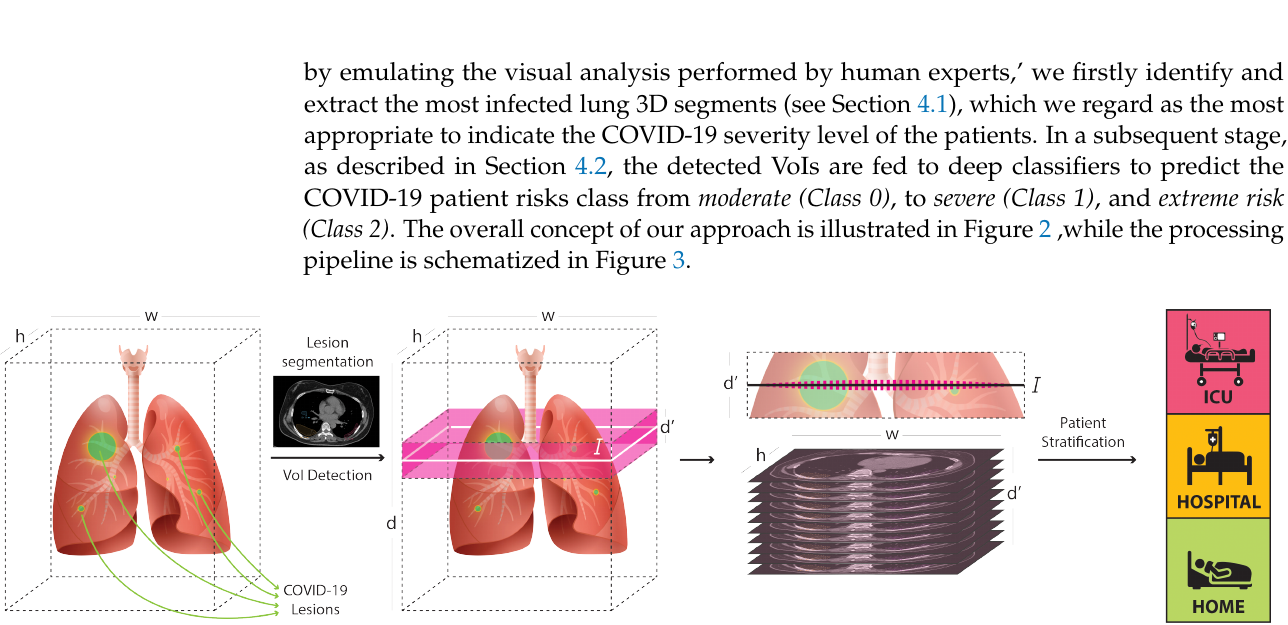
Figure 2. For a CT scan with size w × h × d , where w , h and d are the slice-width, slice-height, and number of slices, respectively, the most informative volume of interest (VoI) is composed by d (cid:48) adjacent slices around I , with I being the most infected slice, that is, the “center of infection.” Discarding the less informative slices, we process the VoI by retaining its detailed information, without any abrupt down-sampling. To this end, the expressive power of the models is focused on the analysis of all the detailed information carried by the salient, informative slices.